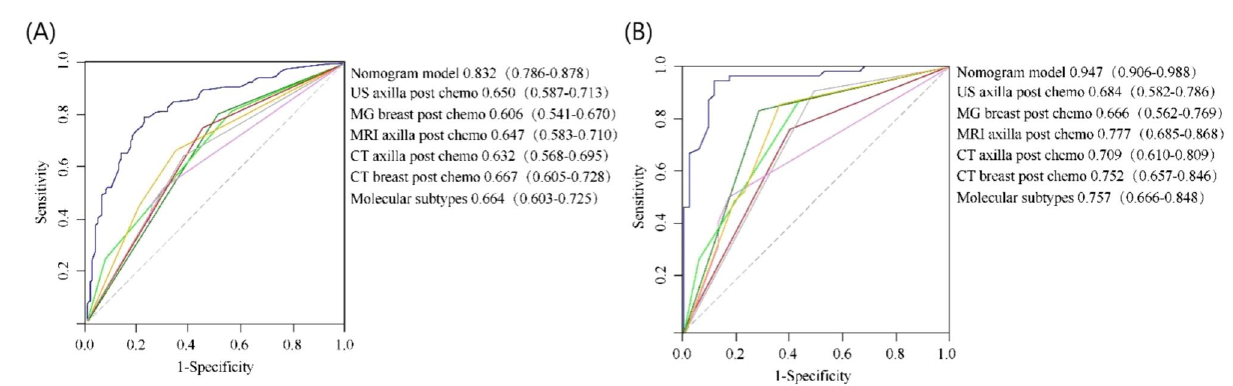
Figure 4. The ROC curve of the nomogram, with an AUC of 0.832 in the training cohort ( A ) and an AUC of 0.947 in the validation cohort ( B